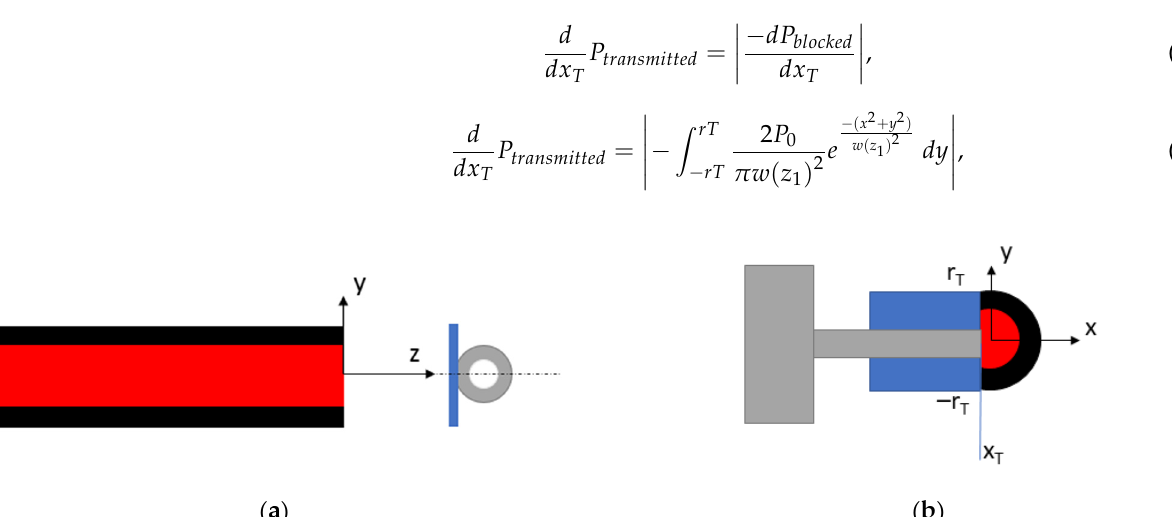
Figure 3. ( a ) Schematic overview of a longitudinal cross-section of verification test setup. The light-emitting fiber is visualized in red. The tip of the Carina middle ear actuator (gray) is placed perpendicular to the fiber axis to block the light traveling through the air gap. A piece of retroreflective tape (blue) is added to ensure that the light bundle could be blocked completely. ( b ) Schematic overview of a cross-section perpendicular to the fiber axis.